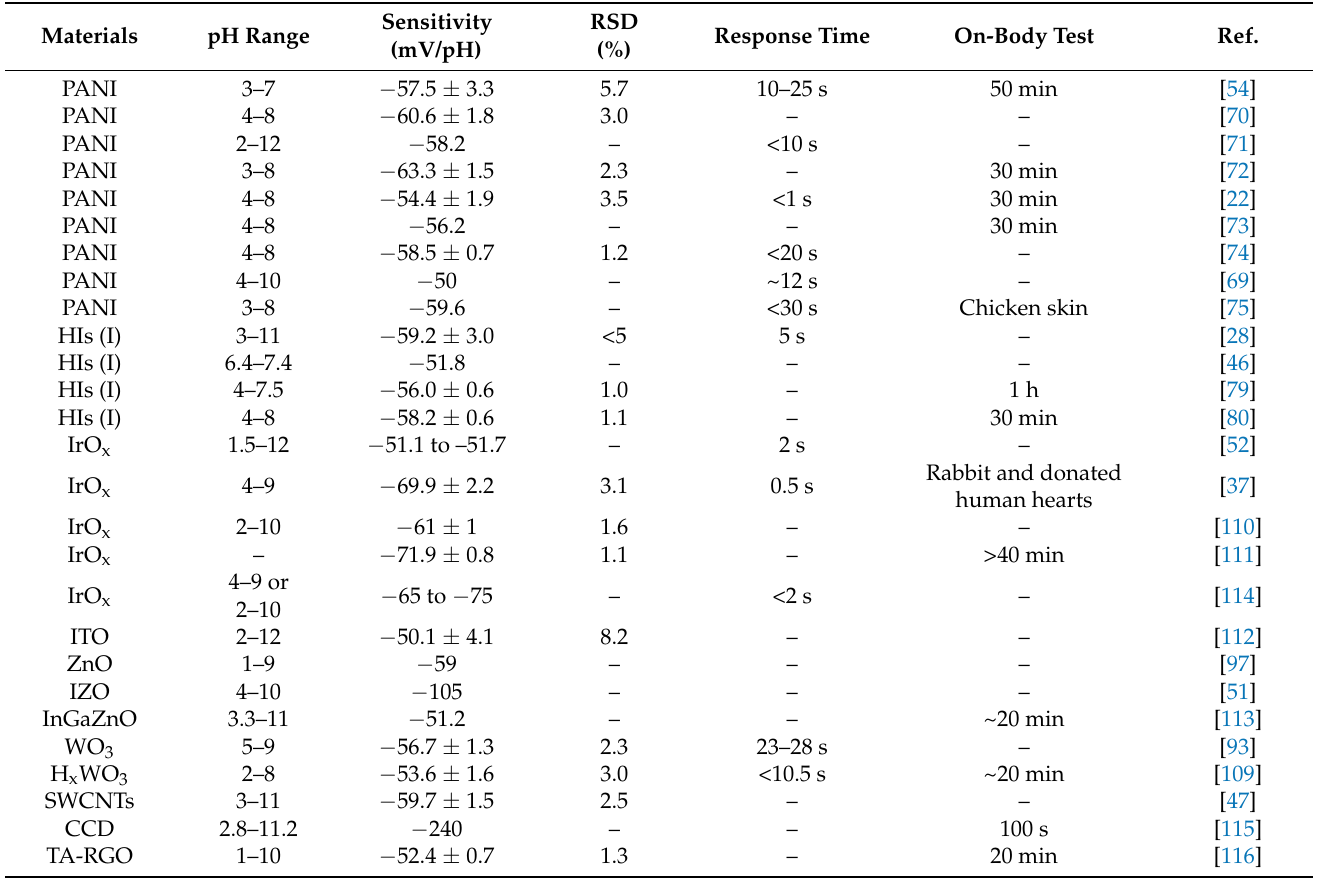
Table 1. Comparison of analytical characteristics of wearable PANI, HIs and MO x pH sensors and sensors based on other